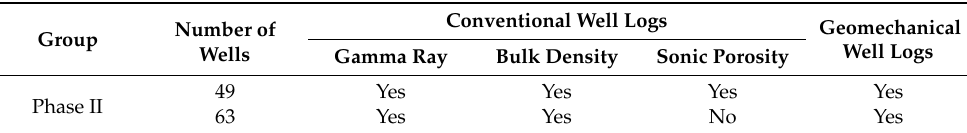
Table 2. Data available for the prediction of Sonic Porosity.